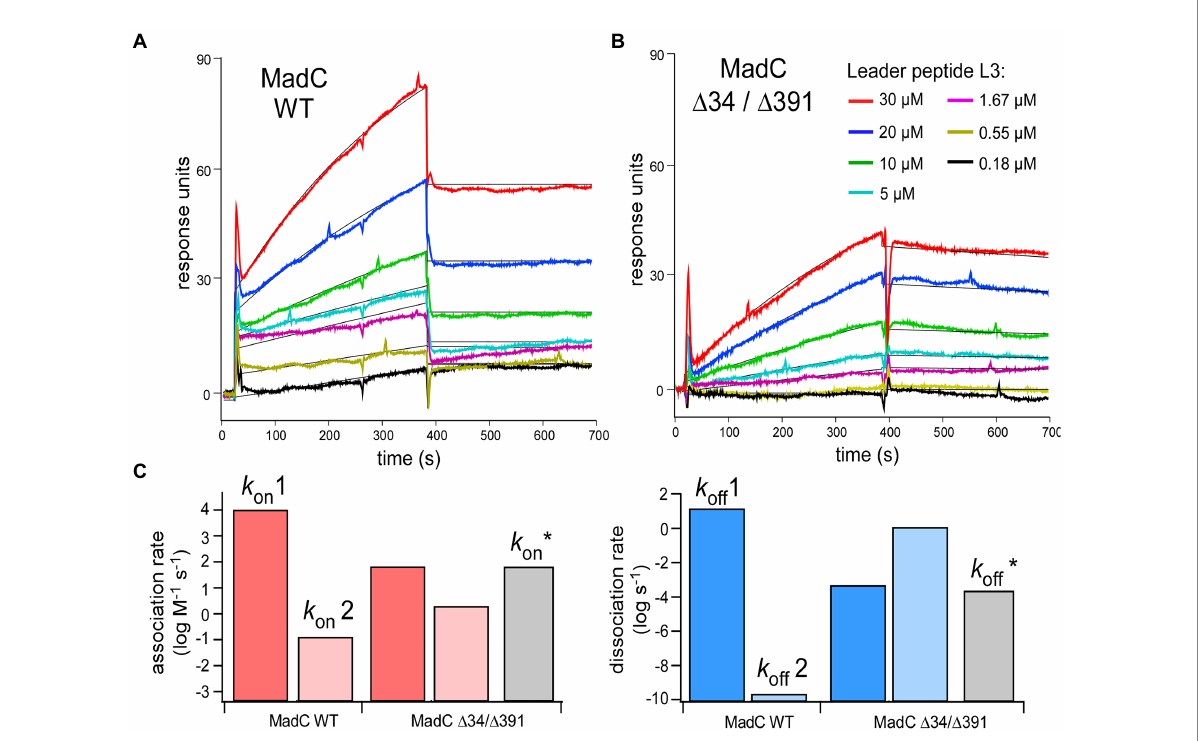
FIGURE 10 (A,B) SPR sensorgrams of MadC:L3 binding recorded for the wild-type and ∆ 34/ ∆ 391 mutant. The color coding for L3 concentrations is provided in the panel (B) Black lines: Fitting to the kinetic model (1:1 binding, two states). (C) Association (left, red) and dissociation (right, blue) rates acquired from the fitting. Grey bars: Association/dissociation rates for MadC ∆ 34/ ∆ 391 mutant acquired from simple 1:1 binding